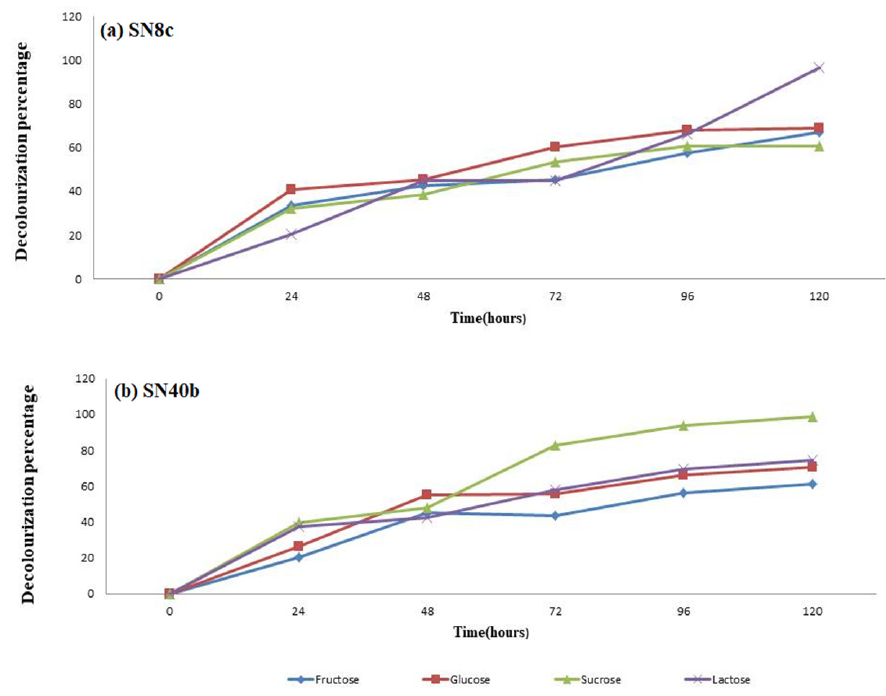
Figure 5. The effect of different carbohydrate sources on the decolorization of RBB dye.